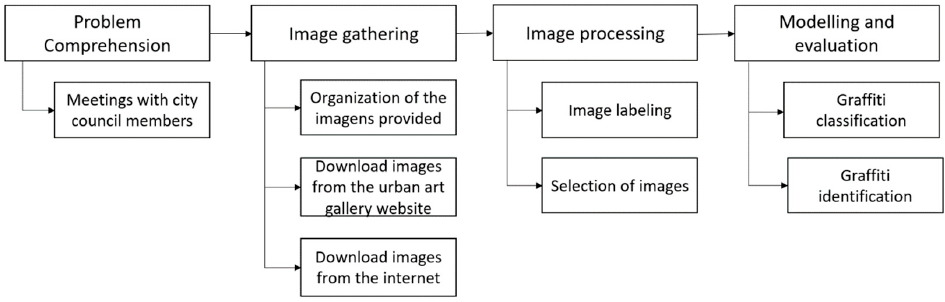
Figure 22. Pipeline implemented for reaching the most suitable models.